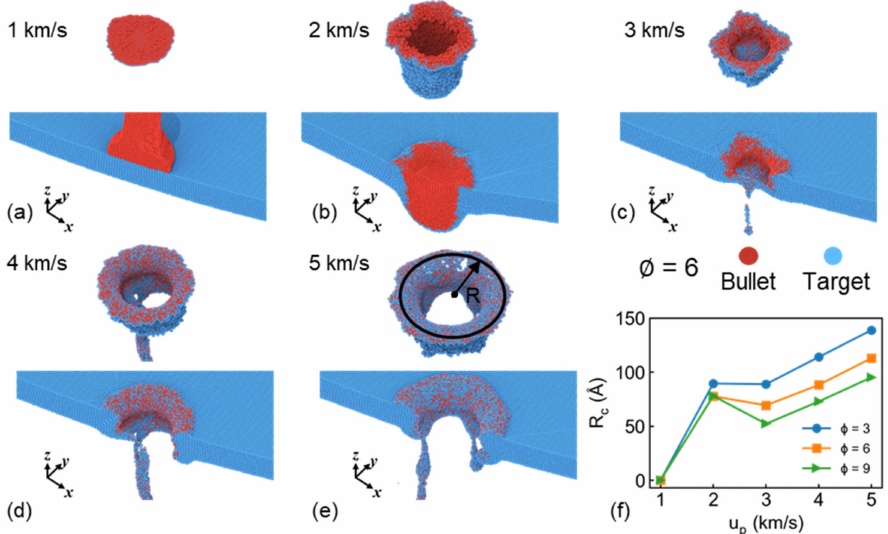
Figure 9. Crater surface and cross-section of sample at 50 ps under u p of ( a ) 1 km/s, ( b ) 2 km/s, ( c ) 3 km/s, ( d ) 4 km/s and ( e ) 5 km/s at the case of ∅ = 6; ( f ) Radius of crater R c under different u p and draw ratio of bullet. Atoms are colored by matter